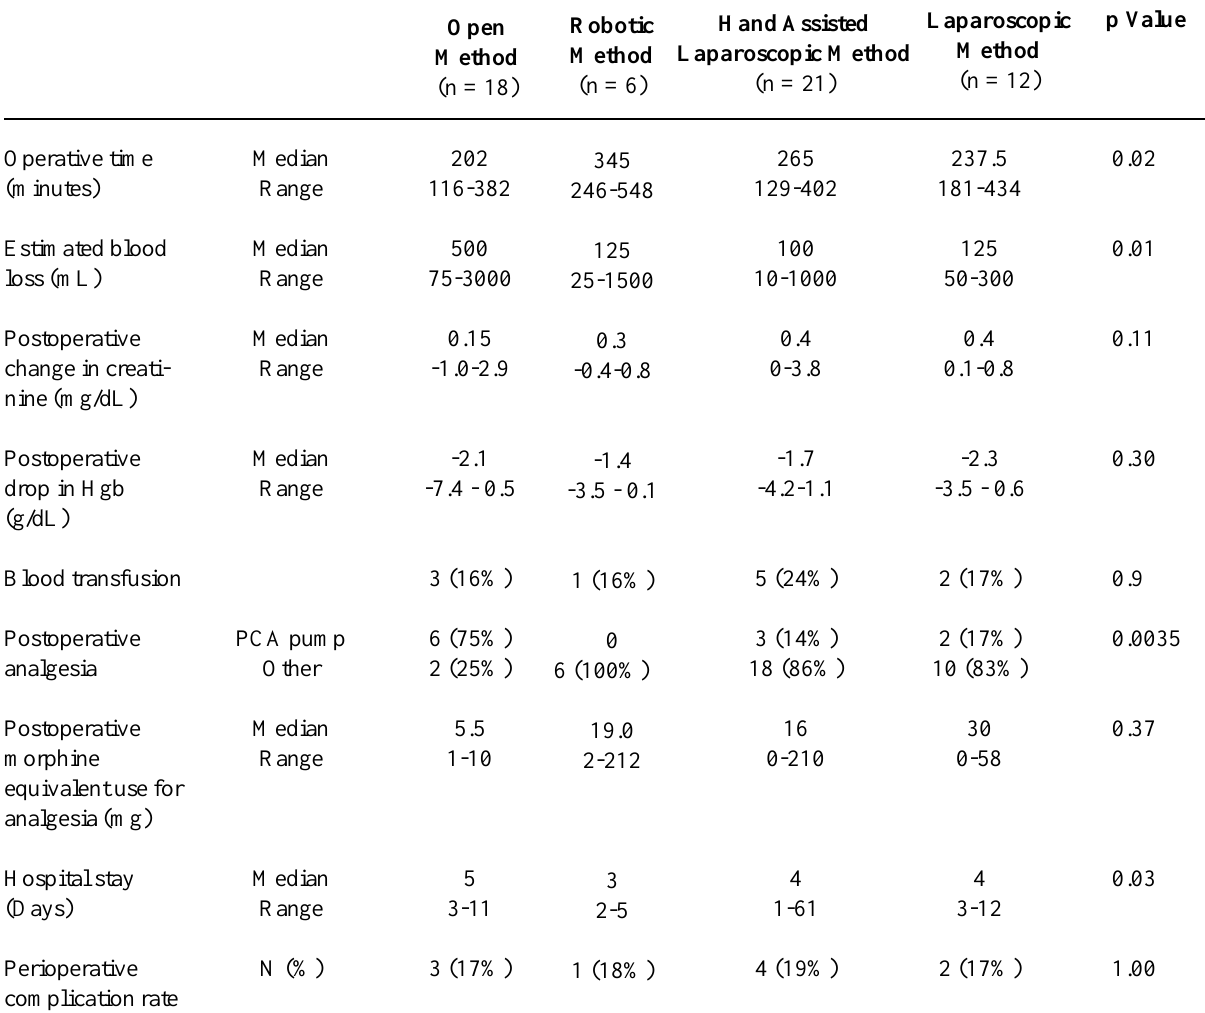
Table 2 – Perioperative outcomes in patients undergoing radical nephrectomy by different methods. Statistically signifi- cant pairwise comparisons (p < 0.01 to adjust for multiple